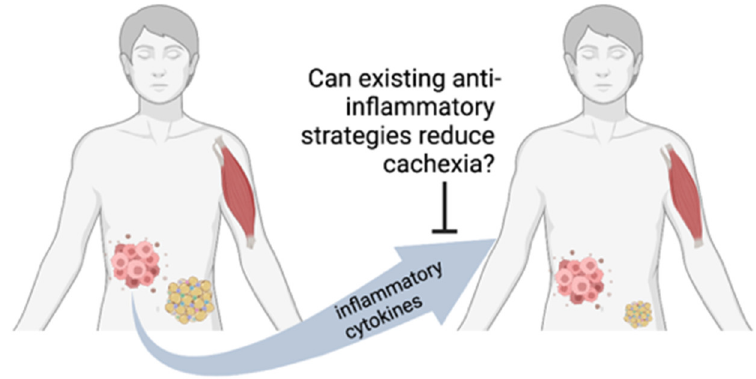
Figure 1. Review question. Created with Biorender.com on 10 October 2022.